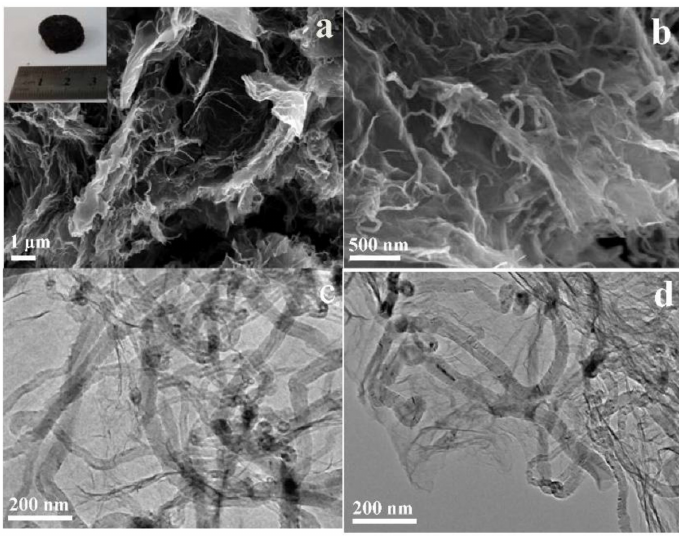
Figure 1. SEM ( a , b ) and TEM ( c , d ) images of Co-N-GCA (inset in ( a ) shows a digital photograph of the prepared aerogel).